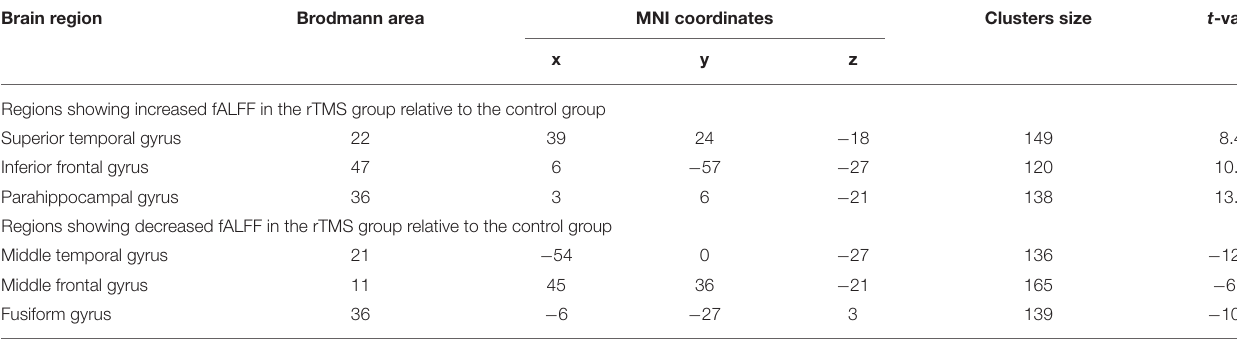
Brain region MNI